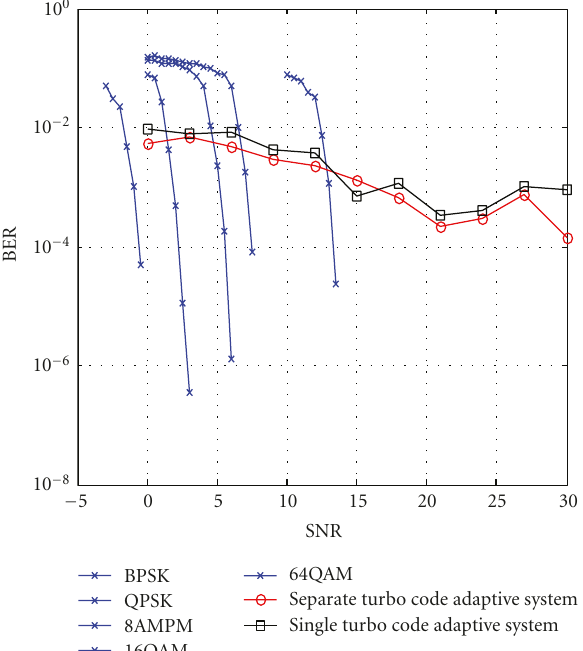
Figure 7: BER of separate turbo code system and single turbo code system.